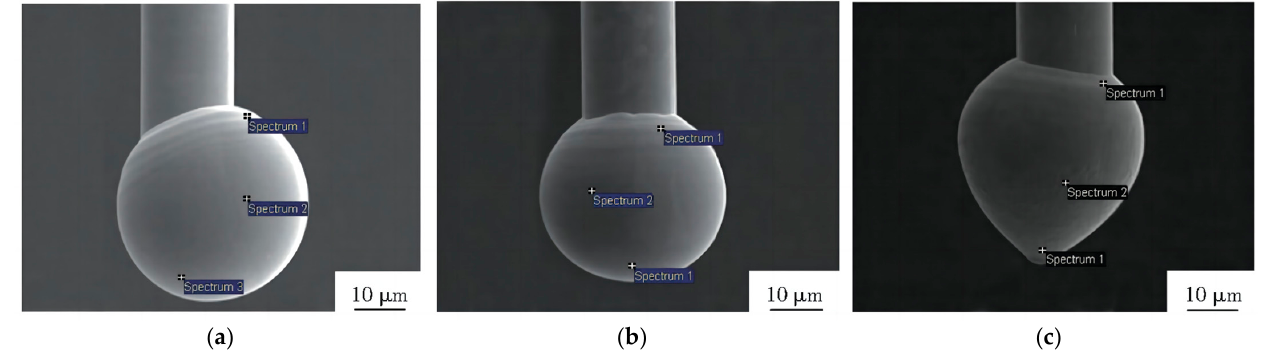
Figure 14. Morphology of FAB for Au-coated Ag bonding wires with ( a ) 48.7 nm, ( b ) 108 nm, and ( c ) 174.7 nm Au coating thickness [156]. Reproduced with permission from Ref. [156]; published by Materials Science and Technology, 2018.